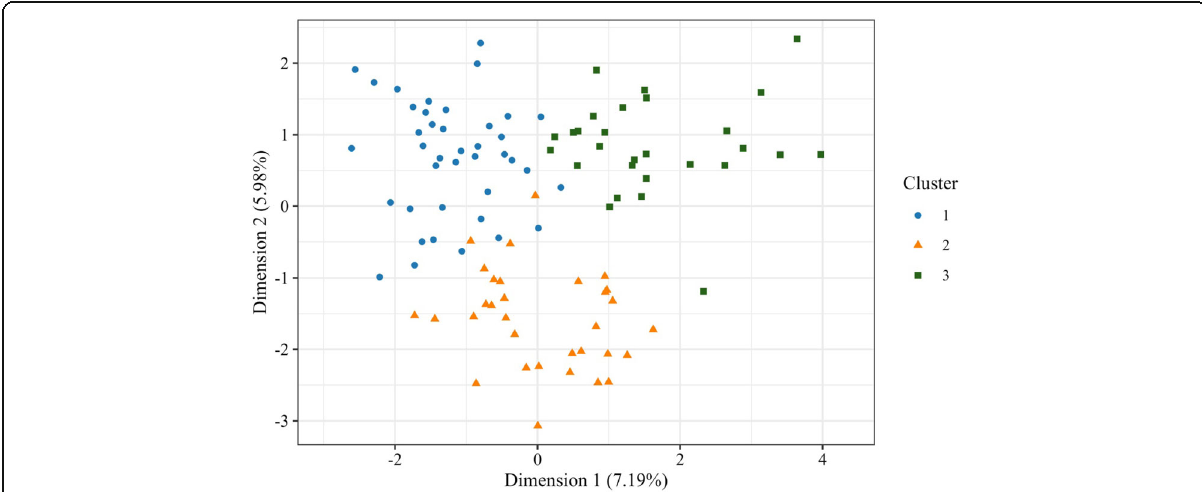
Fig. 2 Biplot in the first two dimensions ’ plane depicting the 3 clusters of farms. Each point represents a farm and each cluster is depicted by a different shape and colour. Labels indicated the anonymized farm